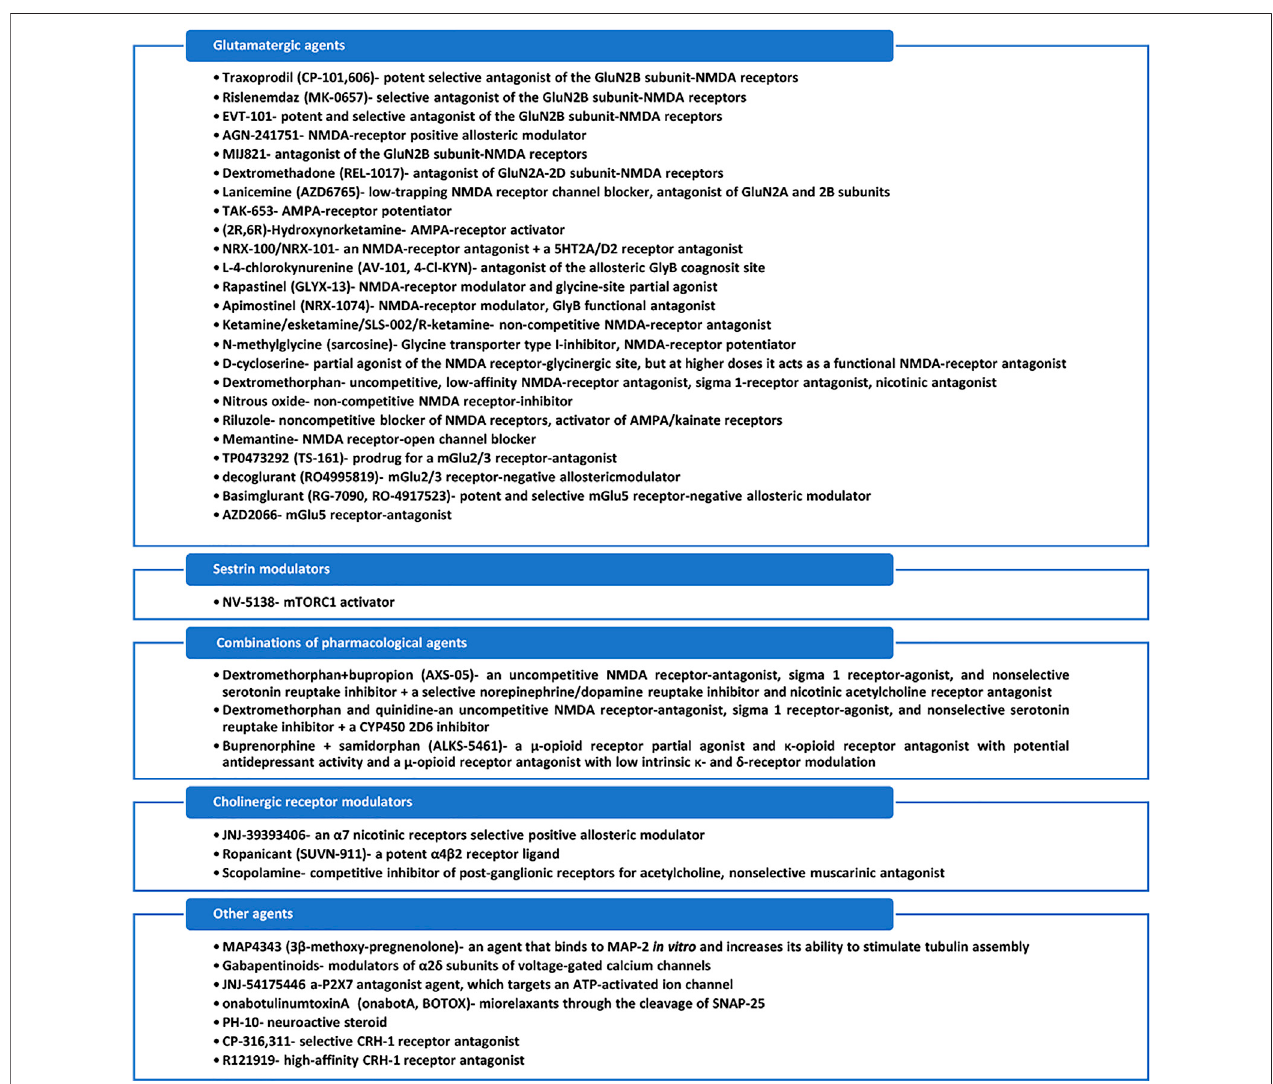
FIGURE 3 | Mechanisms of action of the identi fi ed antidepressants in the pipeline, which are presented in this review.